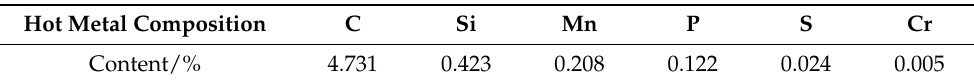
Table 7. Composition of hot metal derived from the 1280 m 3